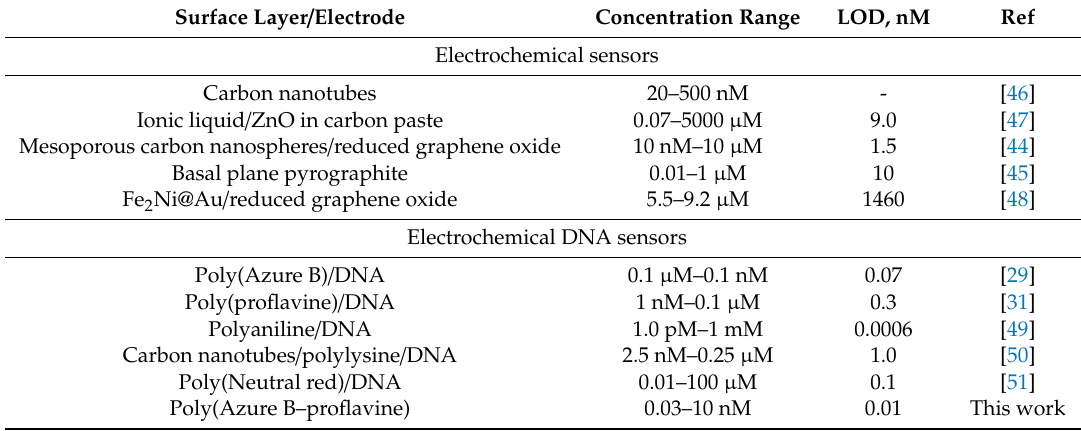
Table 2. Analytical characteristics of the determination of doxorubicin with electrochemical sensors and DNA